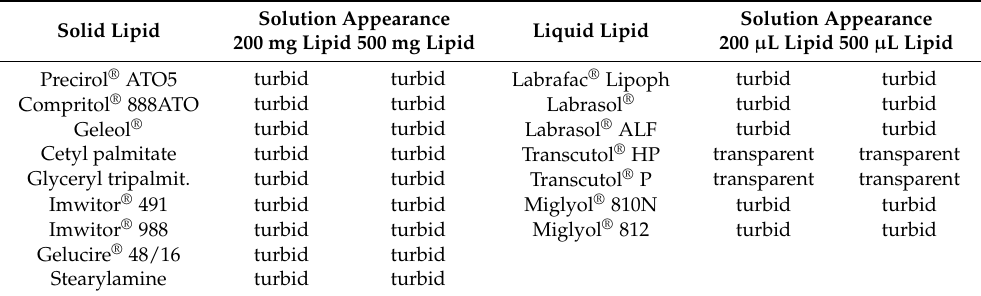
Table 1. Cefixime solubility (in terms of solution transparency or turbidity) in melted solid lipids (80 ◦ C) and in liquid lipids heated at 80 ◦ C (10 mg drug added to 200 or 500 mg solid lipid or 200 or 500 µ L liquid